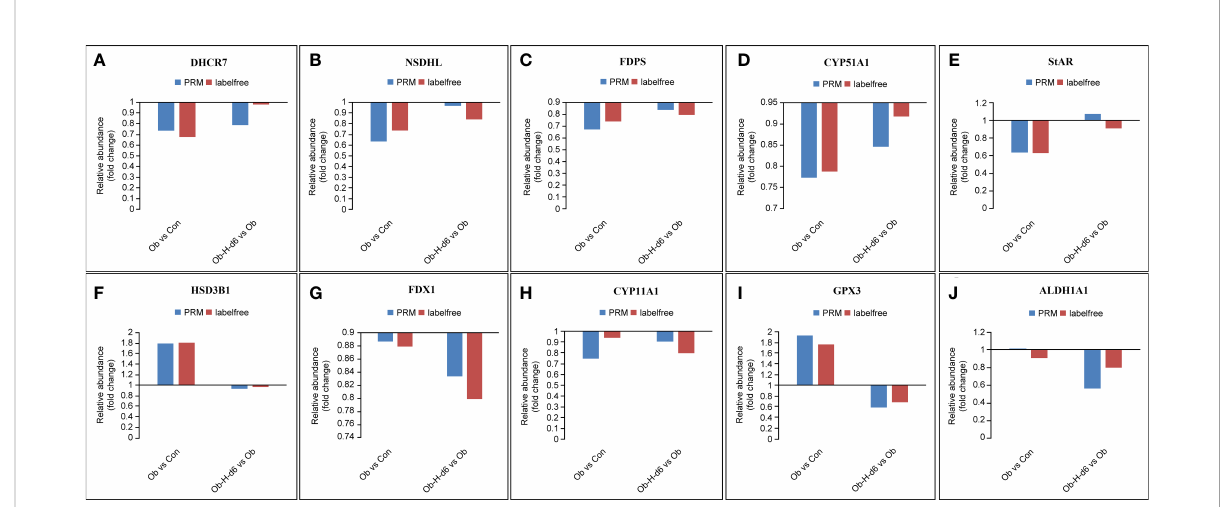
FIGURE 10 Expression patterns of ten representative DEPs using 4D label-free analysis and PRM. (A) DHCR7, (B) NSDHL, (C) FDPS, (D) CYP51A1, (E) StAR, (F) HSD3B1, (G) FDX1, (H) CYP11A1, (I) GPX3, (J) ALDH1A1. Con, Control group; Ob, Obese group; Ob-H, Obese-Hypoxia